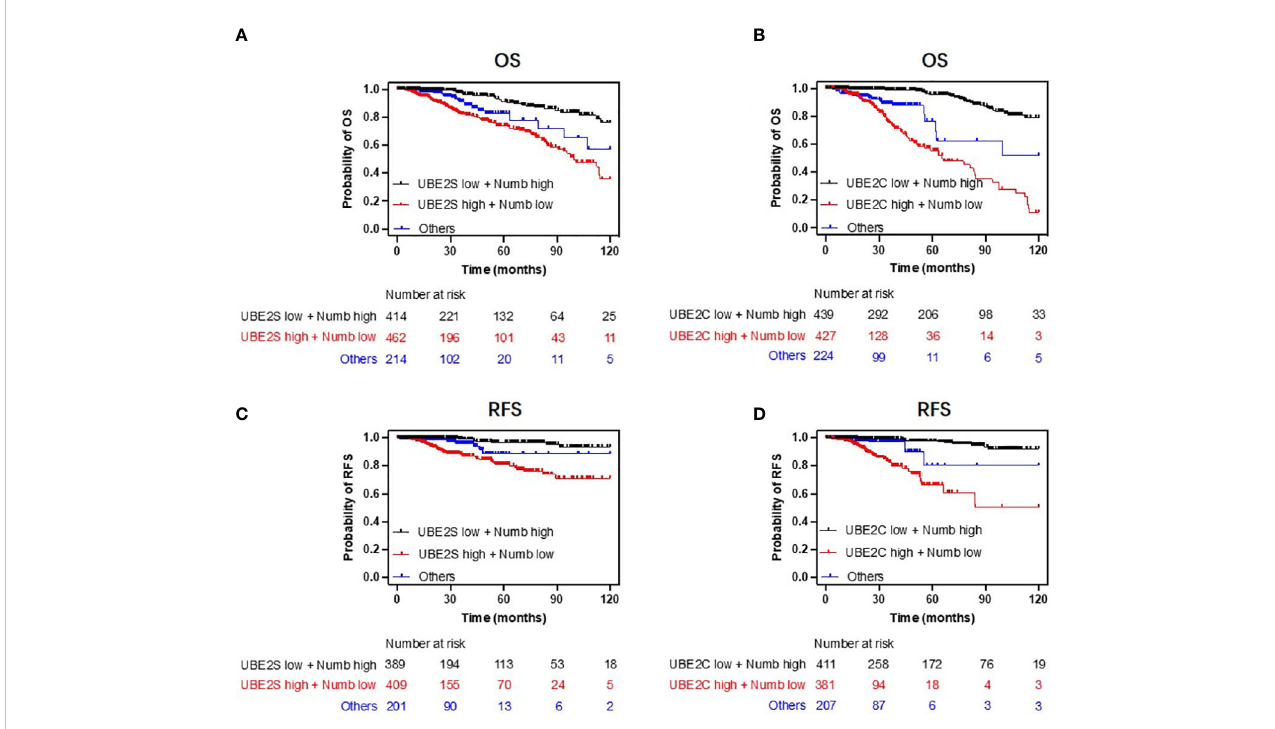
FIGURE 8 Combining UBE2S or UBE2C with Numb predicts breast cancer patients ’ survival. Patients with low UBE2S or UBE2C levels and high Numb expression demonstrated higher OS (A, B) and RFS (C, D) probabilities compared to those with high UBE2S or UBE2C levels and low Numb expression. Univariate regression analyses are presented in Supplementary Table